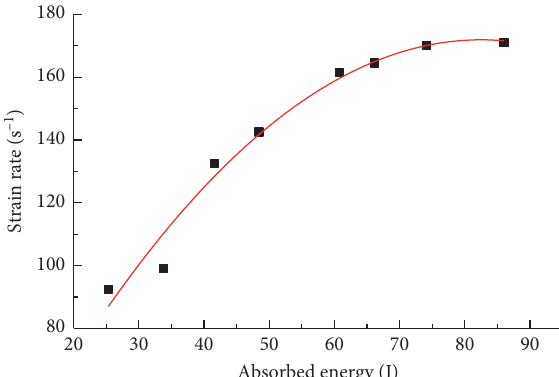
Figure 16: Relation curve between absorbed energy and the average strain rate.